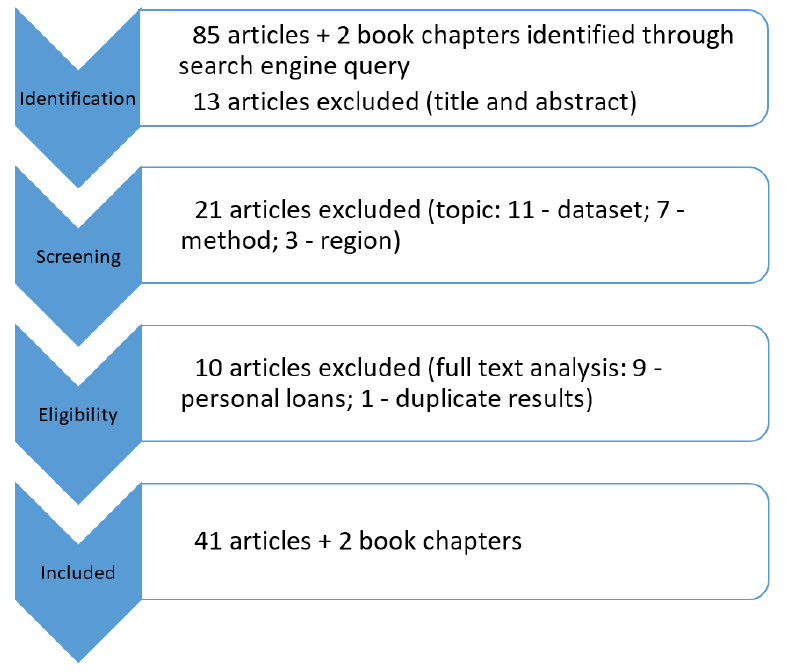
Figure 1. PRISMA diagram detailing the selection process of the identified